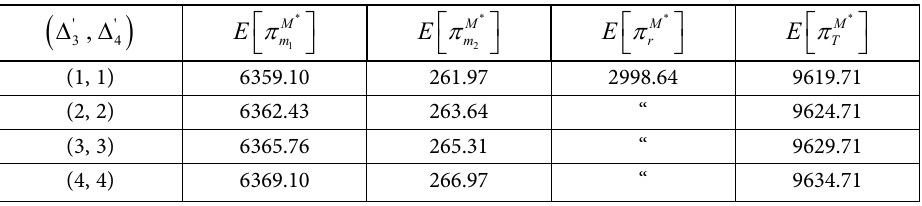
Table 9. Optimal values of the decision